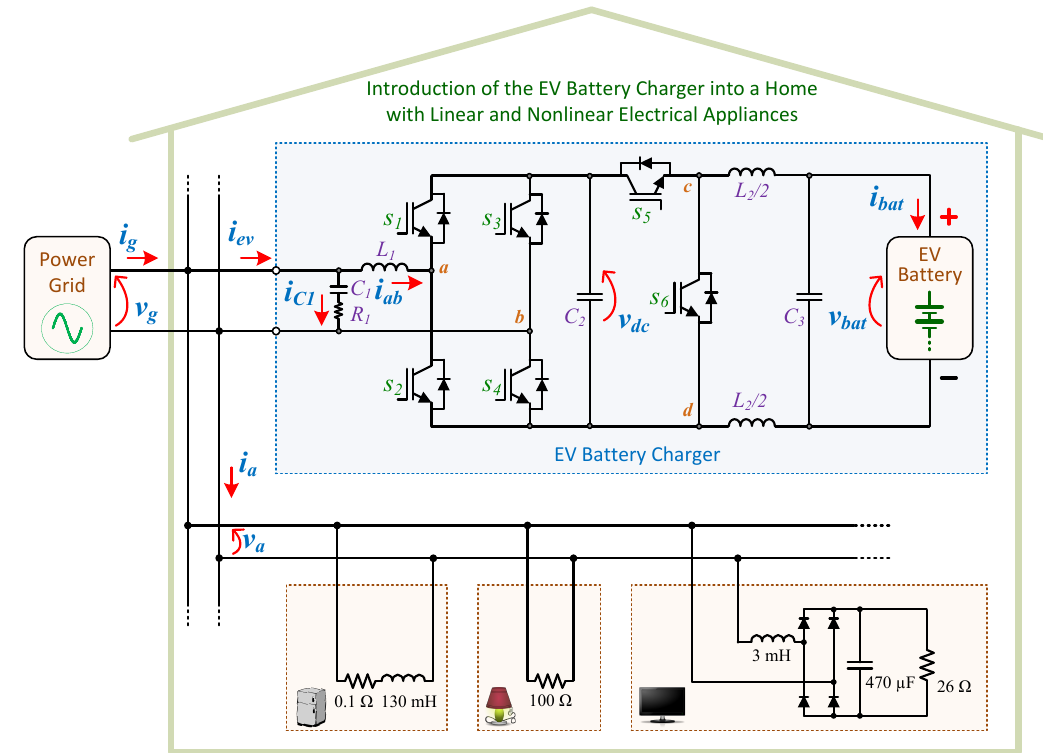
Figure 2. Introduction of the EV battery charger into a smart home and its internal arrangement in terms of power electronics